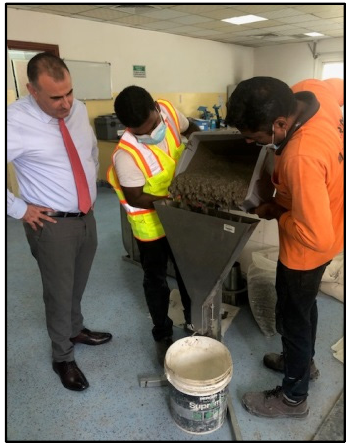
Figure 2. V-funnel test.